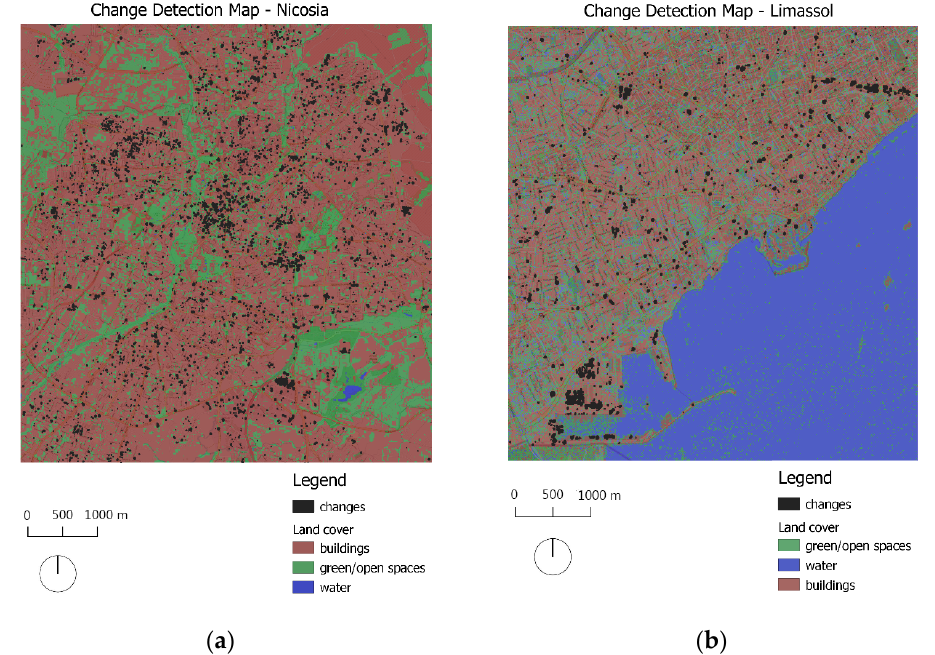
Figure 13. Change detection maps produced by SAR data wherein polygons of changes are overlaid with the classification results: ( a ) Nicosia; ( b ) Limassol.